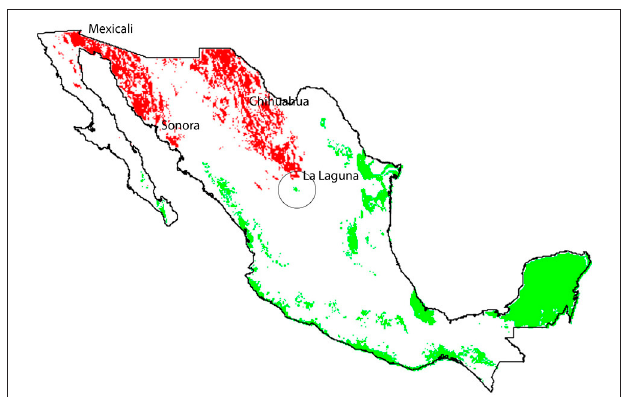
FIGURE 2 | Climatic suitability model for geographical space projection regions for wild cotton G. hirsutum (green dots) and cultivated GM cotton regions (red dots). Regions do not overlap, but show proximity in the area known as “La Laguna” (black